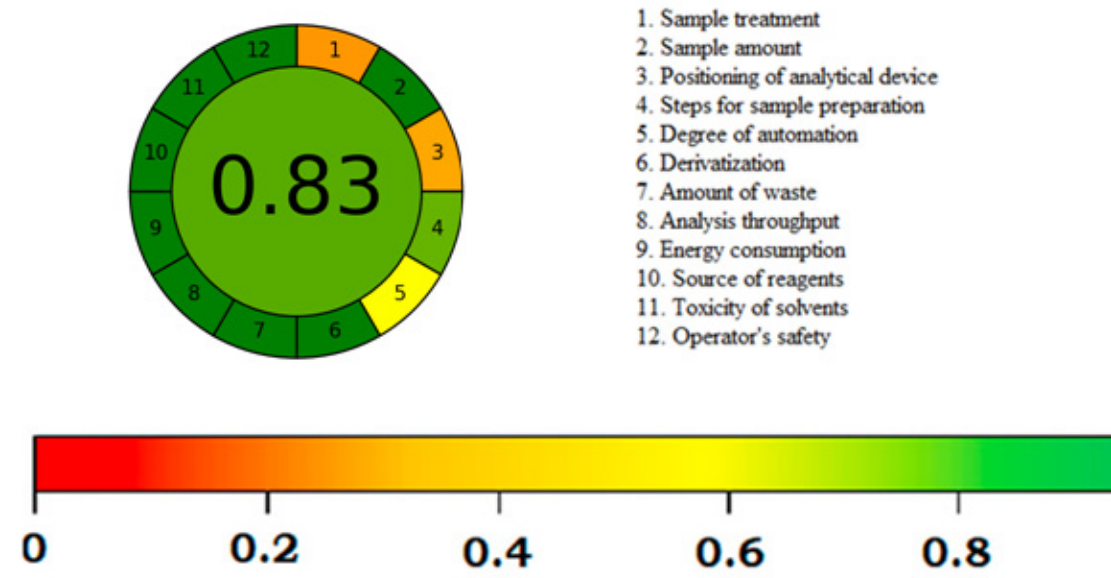
Figure 7. Analytical GREEnness (AGREE) score for the sustainable RP-HPTLC method.